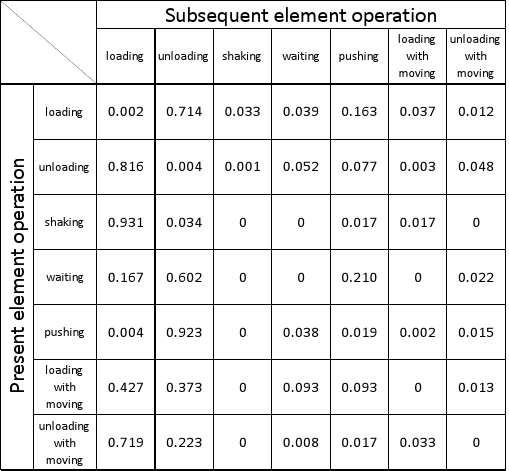
Figure 5. Transition probability matrix of element operations of the grapple excavator.